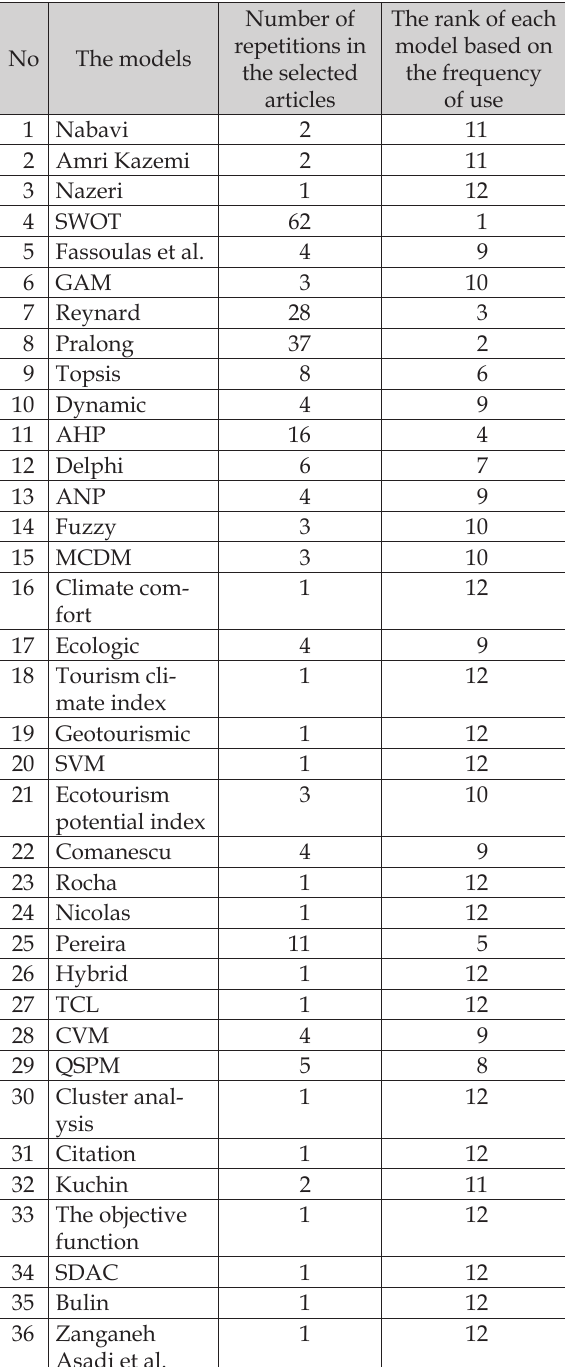
Table 1. The repetition of geosite evaluation models within statistical sample.